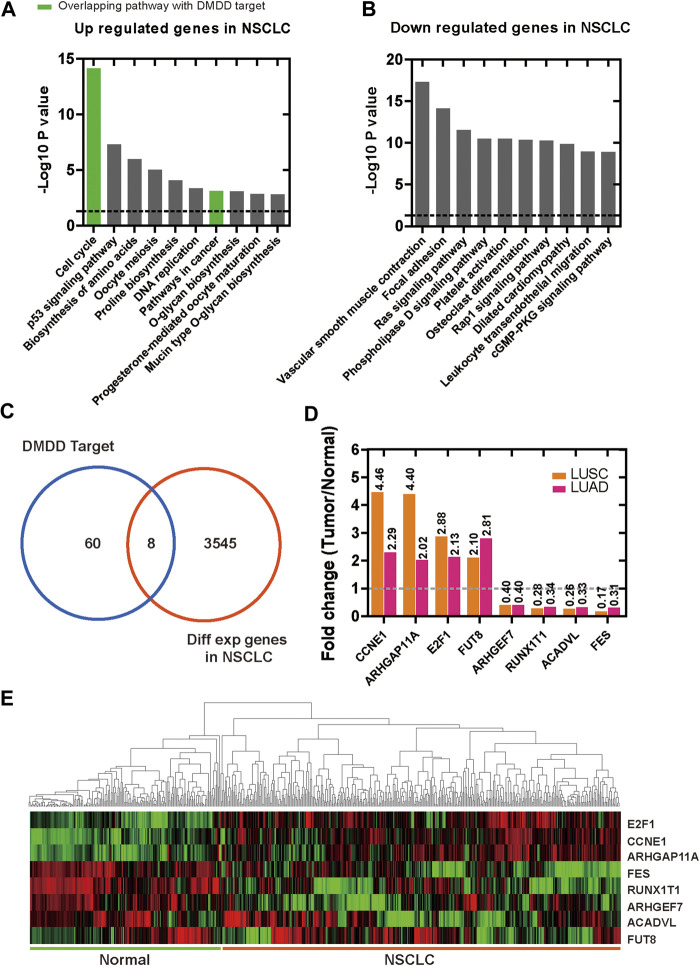
Differentially expressed genes in lung cancer and normal lung tissues. (A) Enrichment of KEGG pathways for up regulated genes in lung cancer. (B) Enrichment of KEGG pathways for down regulated genes in lung cancer. (C) 8 overlapping genes were found between 60 potential therapeutic target proteins of DMDD and lung cancer related DEGs. (D, E)
FUT8, CCNE1, E2F1, ARHGAP11A were upregulated and ARHGEF7, RUNX1T1, ACADVL, FES were down regulated in lung cancer tissues compared with normal lung.